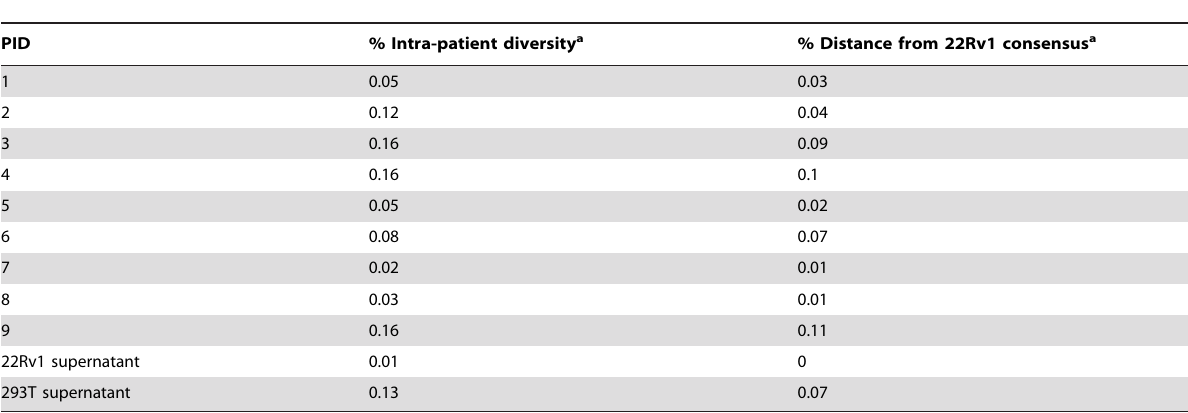
Figure 5. Gag X-SGS on culture supernatants from isolations. (a) Neighbor-joining tree of single-genome gag sequences from XMRV infected 293T cell supernatants, 22R v1 cell supernatants, and supernatants from virus rescue experiments on patients 1–3, and 5. (b) Highlighter plots of the same sequences as compared to XMRV VP62. PreXMRV-1 and -2 and the predicted recombinant (used as outgroup) [18] are included for comparison. doi:10.1371/journal.pone.0030889.g005 Table 3. Pairwise diversity of XMRV env sequences from virus culture samples.